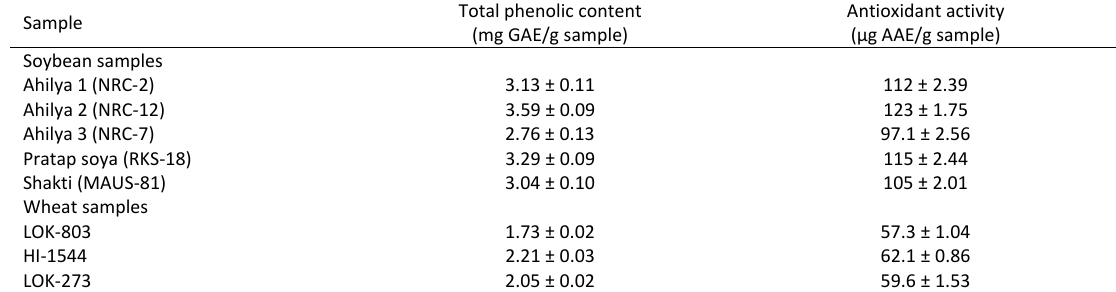
Table 5: Total phenolic content and antioxidant activity of soybean and wheat cultivars